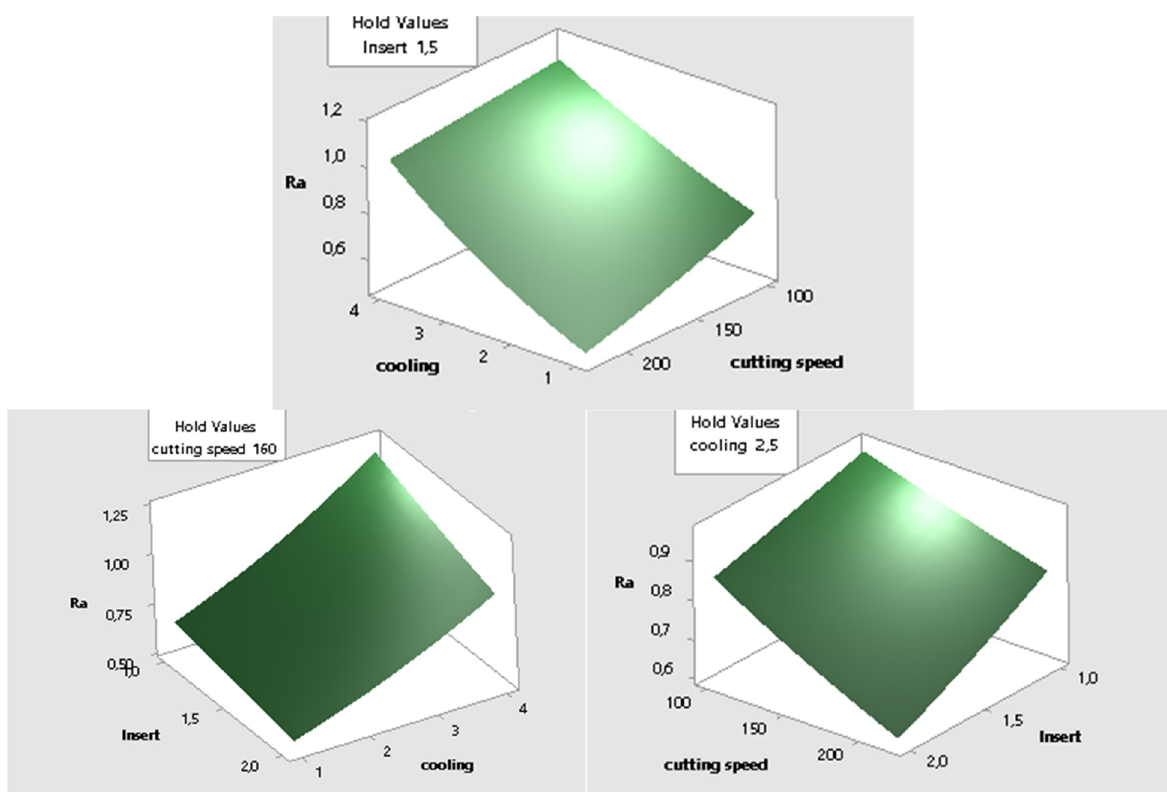
Figure 4: Relation of surface roughness with machinability